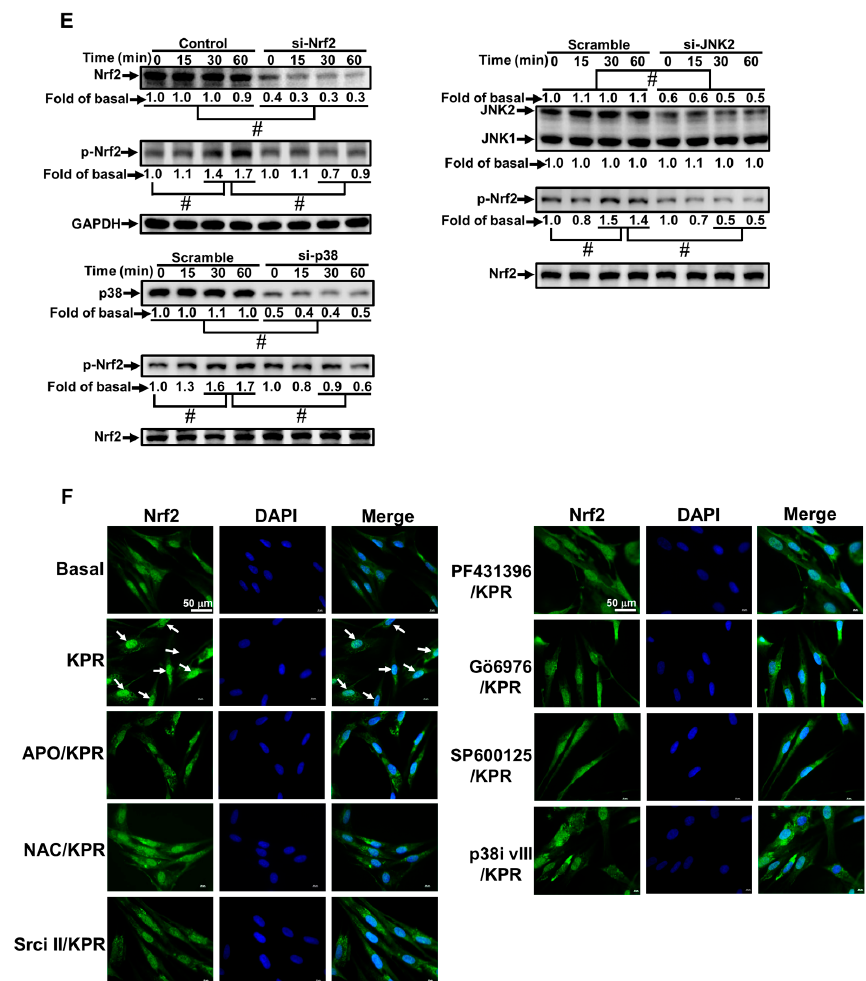
Figure 10. Nrf2 activated by protein kinases is involved in KPR-induced HO-1 expression. ( A ) HPAEpiCs were transfected with scrambled (scrb) or Nrf2 siRNA, and then incubated with DMSO or KPR (10 µ M) for 16 h. The protein expression of HO-1 was determined by Western blot analysis using GAPDH as a loading control. ( B ) Cells were transfected with scrambled (scrb) or Nrf2 siRNA, and then incubated with DMSO or KPR (10 µ M) for 6 h. The HO-1 mRNA expression was analyzed by real-time PCR. ( C ) HPAEpiCs were co-transfected with ARE promoter-Luc gene and β -galactosidase and then incubated with KPR (10 µ M) for the indicated time intervals. The levels of Nrf2 binding with ARE were examined by a luciferase reporter assay kit. Cells were pretreated with APO (100 µ M), NAC (1 mM), or Srci II (10 µ M) for 1 h and then incubated with KPR (10 µ M) for 6 h. ARE promoter activity was determined by a luciferase reporter assay kit. ( D ) Cells were incubated with KPR (10 µ M) for the indicated time intervals (upper). The cells were pretreated with APO (100 µ M), NAC (1 mM), Srci II (10 µ M), PF431396 (10 µ M), or G˝o6976 (3 µ M) for 1 h, and then incubated with KPR (10 µ M) for 1 h (bottom). The DNA binding activity of Nrf2 on ARE1 was determined by chromatin immunoprecipitation assay. The immunoprecipitated DNA was analyzed by real-time qPCR with SYBR Green. ( E ) Cells were transfected with scrambled (scrb), p38, JNK2, or Nrf2 siRNA, and then incubated with KPR (10 µ M) for the indicated time intervals. The levels of phospho-Nrf2, total Nrf2, p38, and JNK2 were determined by Western blot. ( F ) The cells were pretreated without or with APO (100 µ M), NAC (1 mM), Srci II (10 µ M), PF431396 (10 µ M), G˝o6976 (3 µ M), SP600125 (10 µ M), or p38i VIII (10 µ M) for 1 h, and then incubated with KPR (10 µ M) for 30 min. The localization and expression of Nrf2 were determined by immunofluorescent staining (green) and nuclei were stained with DAPI (blue). Scale bar: 50 µ m. Data are expressed as mean ± SEM ( n = 5), analyzed with one way ANOVA and Dunnett’s post hoc test. # p < 0.01, as compared with the cells exposed to vehicle alone; or significantly different as